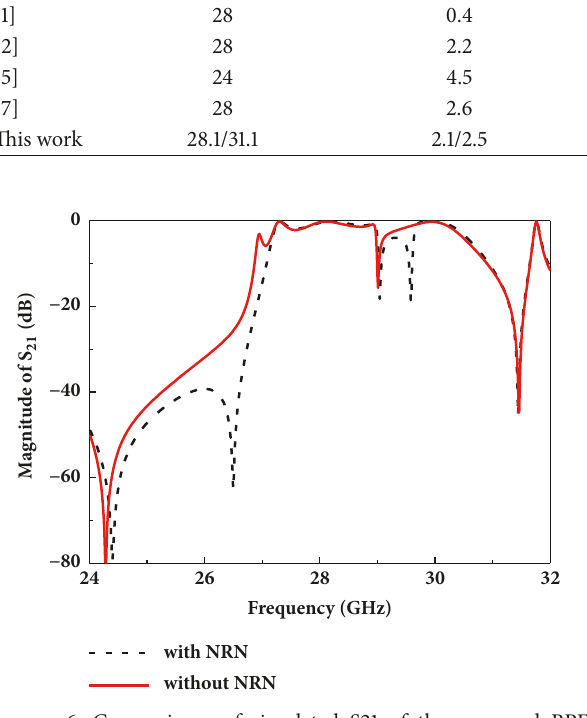
Figure 6: Comparisons of simulated S21 of the proposed BPF (solid line: filter without nonresonating node; dash line: filter with measured nonresonating node).